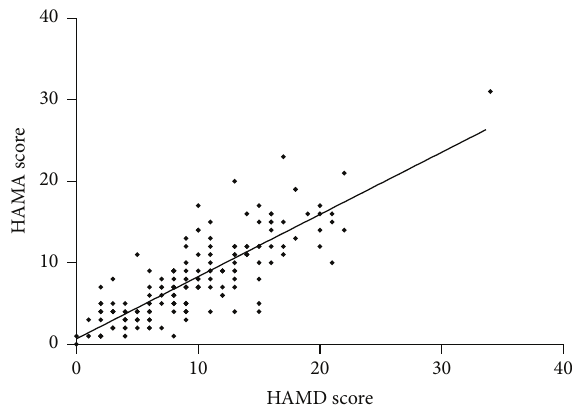
Figure 2: The correlation between HAMD and HAMA scores ( 𝑟 = 0.82 , 𝑝 = 0.000 ).